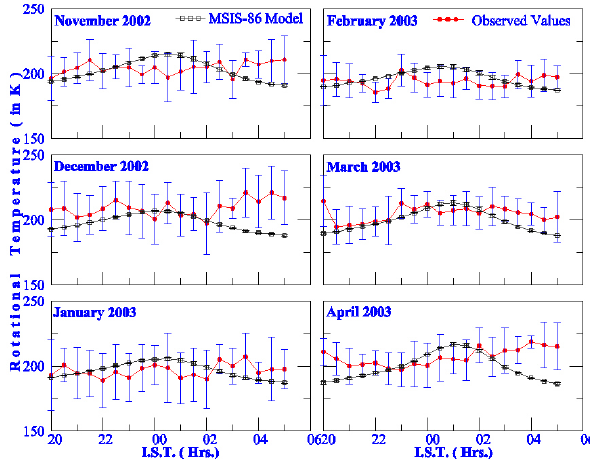
Fig. 7. Half-hourly means of the measured rotational temperature over the period 2 November 2002 to 29 April 2003. The vertical arrows show the standard deviation ( ± sigma) in the observed val- ues. Temperature parameters computed from MSIS (1986) model are also depicted in the figure for the corresponding